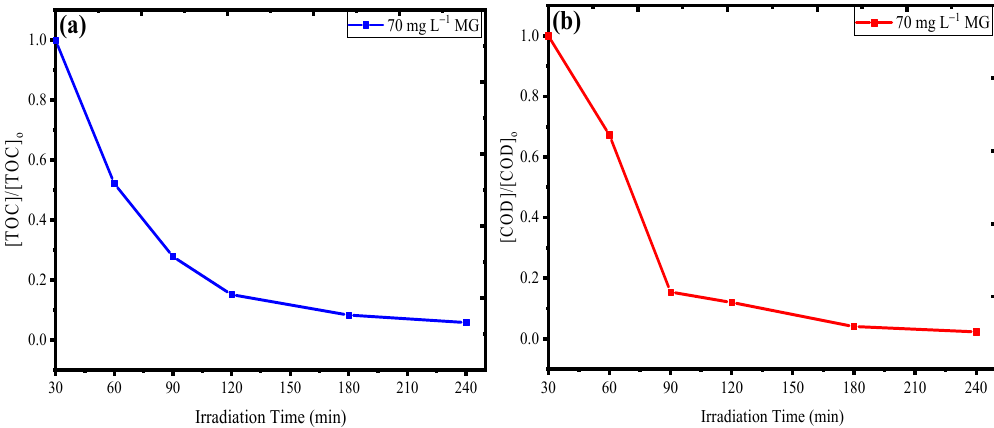
Figure 12. Mineralization of MG during the sonophotocatalysis with CTAS@NIFE for ( a ) total organic carbon (TOC) study and ( b ) chemical oxygen demand (COD) study.